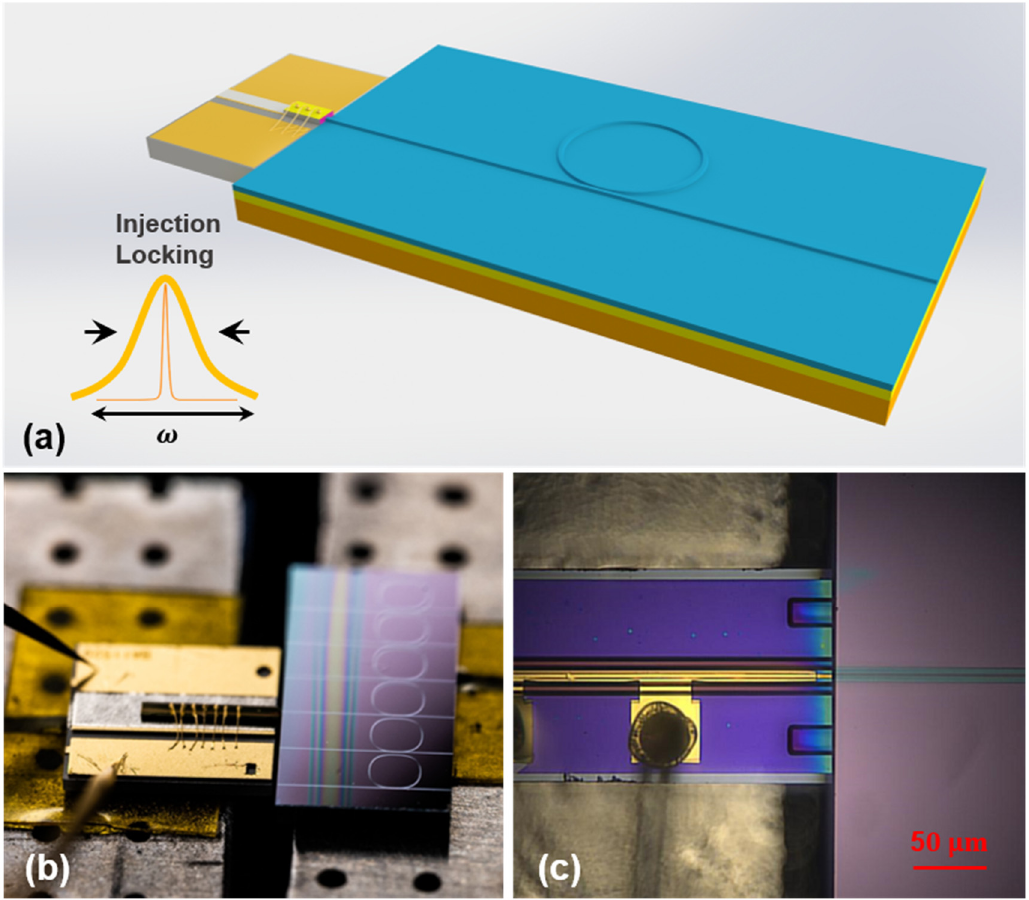
Figure 4. ( a ) Illustration scheme of the narrow linewidth self-injection-locked laser, which is com- posed of a commercial CoS laser diode and a high-Q LN microring laser. ( b ) A photograph of the proposed self-injection-locked laser is taken by a camera. ( c ) Close-up optical micrograph of the interface between the CoS laser diode and LN microring.